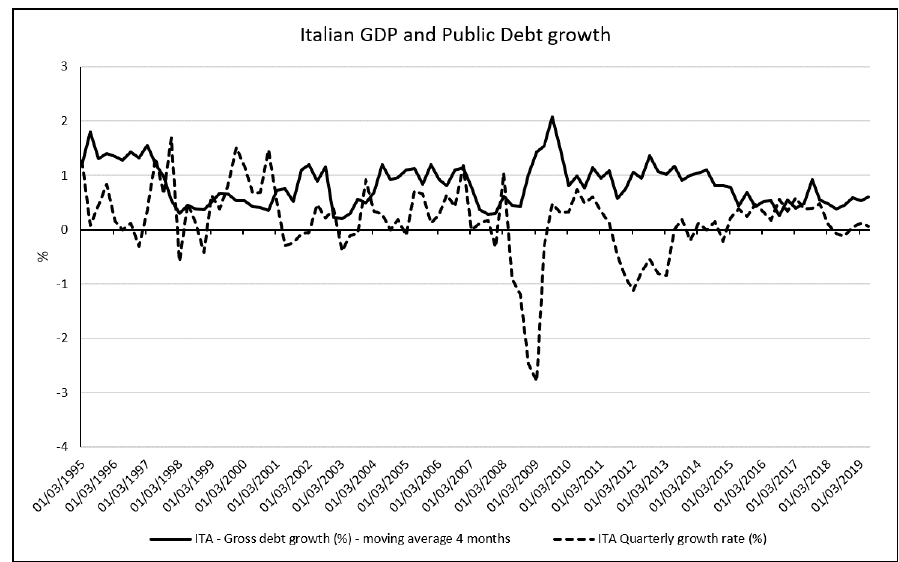
Figure 7. Italian Debt growth rate and the Italian GDP growth rate for the period from 1995:Q1 to 2019:Q2. (data source: Bank of Italy, 2019, ‘own